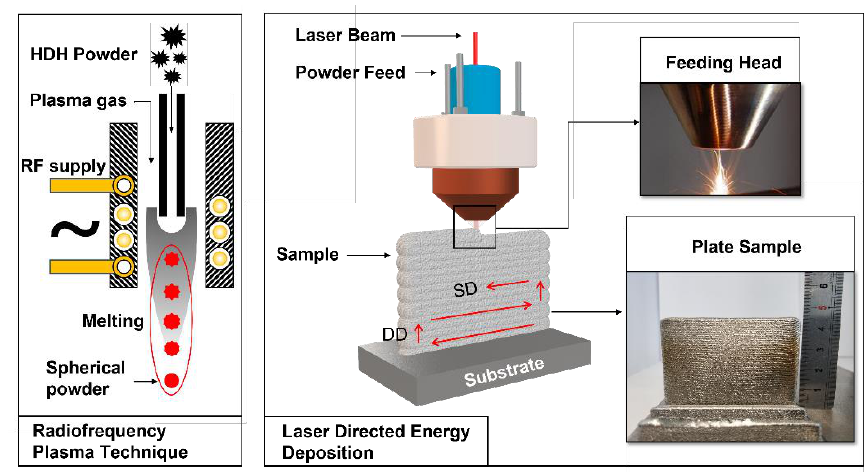
Figure 1. Schematic of the RF technique and the LDED fabrication process for Ti samples.